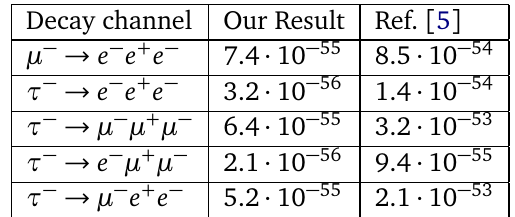
Table 2: Branching ratios including all contributions (interferences are not ne- glected), which are obtained using the current knowledge of the PMNS matrix. The last column values correspond to the approximation where external masses and mo- menta are neglected [ 5 ] . Our results are smaller than those by around one (two) orders of magnitude for the µ ( τ )